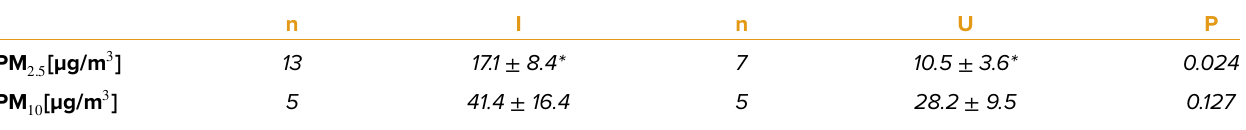
Table 1. PM levels in both studied areas are expressed as the annual average. The results are expressed as mean ± SD. The asterisk denotes significant differences ( P < 0.04) in PM 2.5 levels between populations I and U.